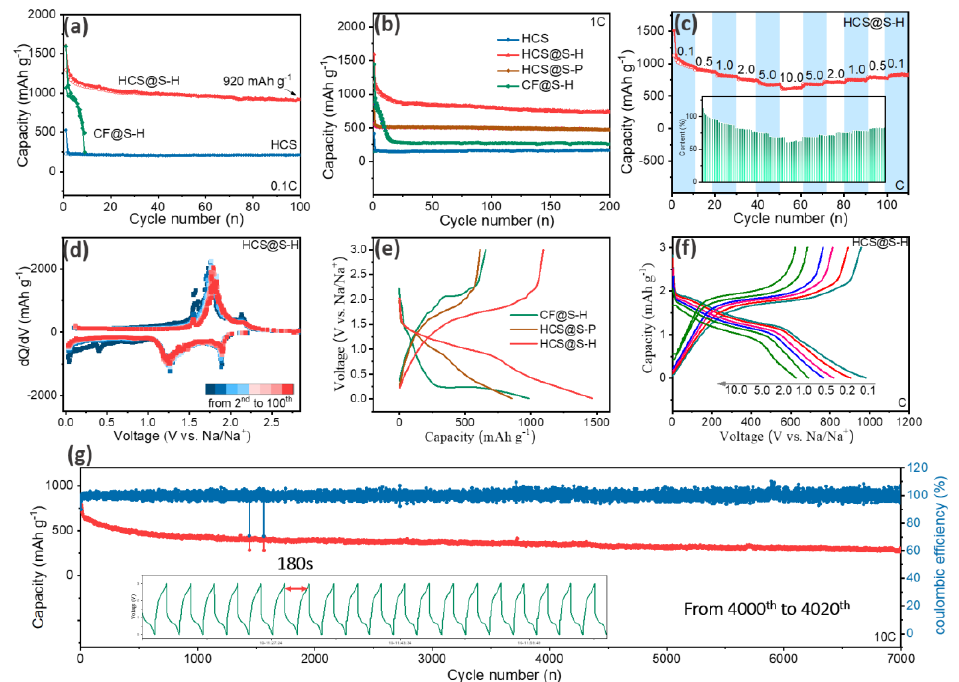
Figure 4. The investigation of electrochemical properties: Cycling stabilities at 0.1 C ( a ) and 1.0 C ( b ), rate properties of HCS@S-H ( c ), differential median curves at different cycles ( d ), the 10th dis- charge/charge platforms ( e ), the platforms of HCS@S-H at different cycles ( f ) and the long-term cycling stabilities at 10.0 C ( g ).